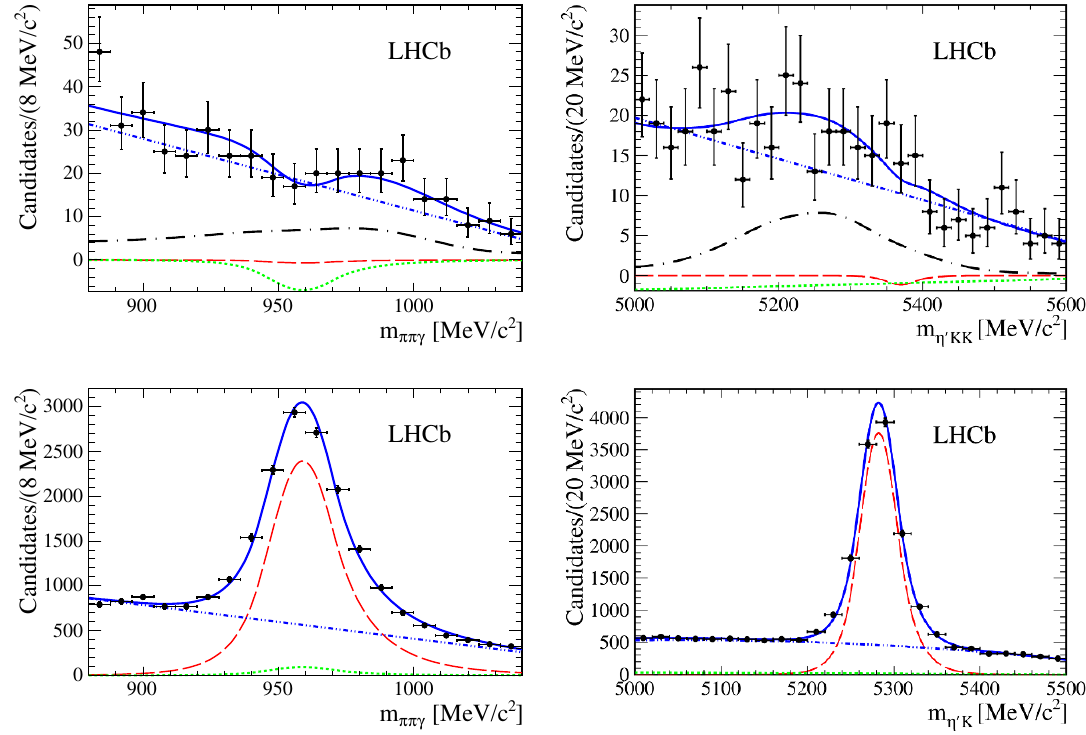
Figure 2 . Distributions of the (top left) (cid:25) + (cid:25) (cid:0) (cid:13) and (top right) (cid:17) 0 K + K (cid:0) masses of the selected B 0 (cid:17) 0 (cid:30) candidates, as well as of the (bottom left) (cid:25) + (cid:25) (cid:0) (cid:13) and (bottom right) (cid:17) 0 K + masses of the s ! selected B + (cid:17) 0 K + candidates. The solid blue curves represent the result of the simultaneous two- ! dimensional (cid:12)t described in the text, with the following components: B 0 (cid:17) 0 (cid:30) and B + (cid:17) 0 K + s ! ! signals (red dashed), combinatorial backgrounds (blue dot-dot-dashed), combinatorial backgrounds with real (cid:17) 0 (green dotted), and B 0 (cid:30)(cid:30) background (black s !